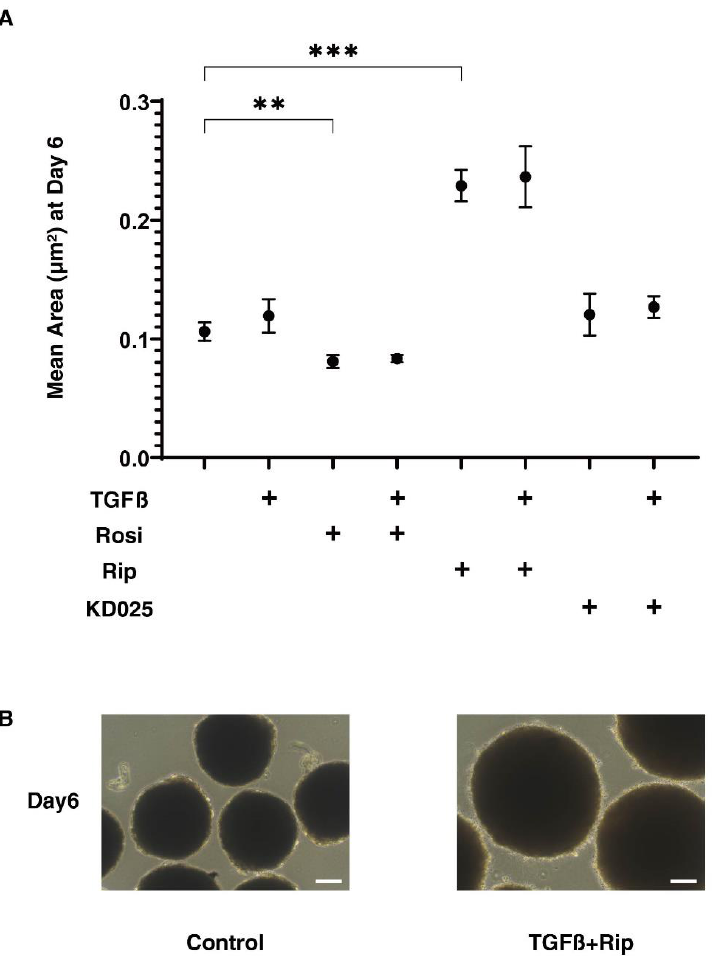
Figure 2. Mean sizes of 3D HconF organoids in the absence or presence of TGF β 2 and/or rosiglita- zone, ripasudil or KD025.The following eight experimental groups included: (1) control for (2), (2) treated with 5 ng/mL TGF- β 2 (TGF β ), (3) treated with 10 µ M rosiglitazone (Rosi); control for (4), (4) treated with TGF β and Rosi, (5) treated with 50 µ M ripasudil (Rip); control for (6), (6) treated with TGF β and Rip, (7) treated with 50 µ M KD025; control for (8) and (8) treated with TGF β and KD025.Mean sizes of 3D HconF organoids at Ddy 6 were measured and plotted (panel A ). All experiments were performed in triplicate using fresh preparations consisting of 16 organoids each. Representative phase contrast images of control and TGF β and Rip at day 6 are shown in (panel B ) (scale bar: 100 µ m). Data are presented as the arithmetic mean ± standard error of the mean (SEM). ** p < 0.01, *** p < 0.005 (ANOVA followed by a Tukey’s multiple comparison